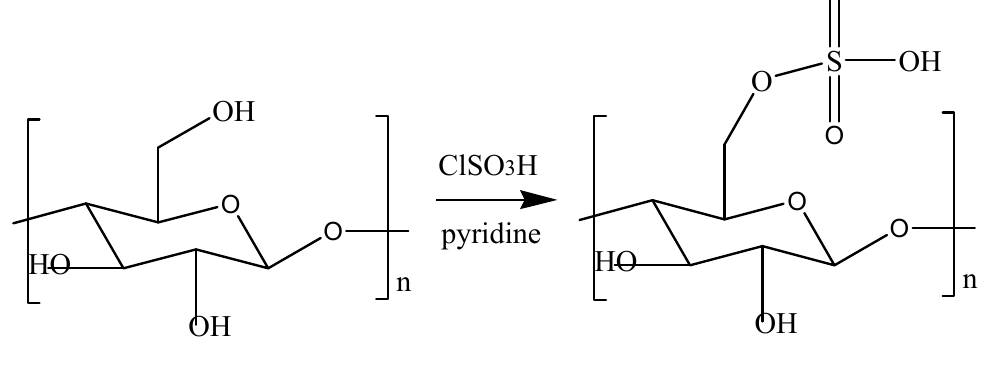
Figure 1. Sulfation of